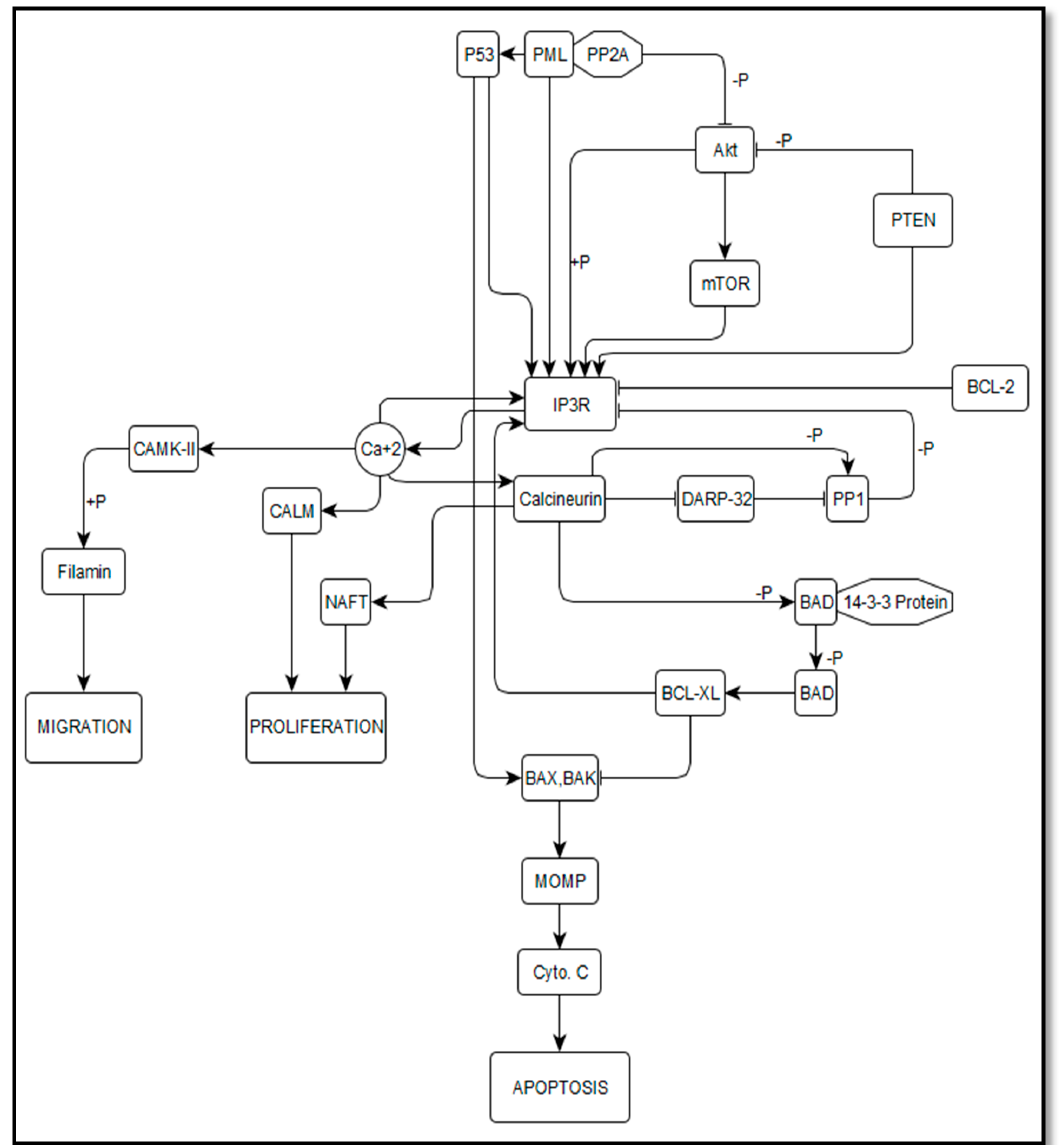
Figure 1. Biological regulatory network (BRN) of IP 3 R with tumor suppressor and onco-proteins. The IP 3 mediated Ca +2 signals play an important role in cell proliferation via the Nuclear Factor of Activated T-cells (NFAT) pathway triggered by Calcineurin. It also mediates cell migration by activating Ca 2+ /CaM-dependent phosphatase and Ca 2+ /CaM-kinases (CaMK). Whereas upon inhibition of IP 3 R, the activated Calcineurin also triggers the downstream apoptotic pathway by de-phosphorylating BAD that results in activation of members of the Bcl-2/Bax family.